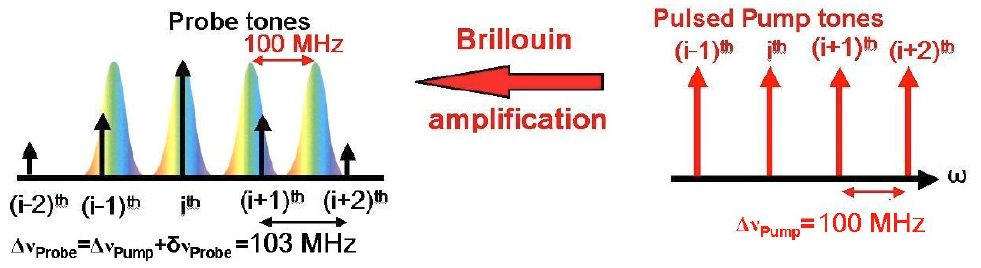
Figure 16. SBS interaction between a multi-tone pump wave and a multi-tone probe wave as done in the frequency-sweep free method [63].